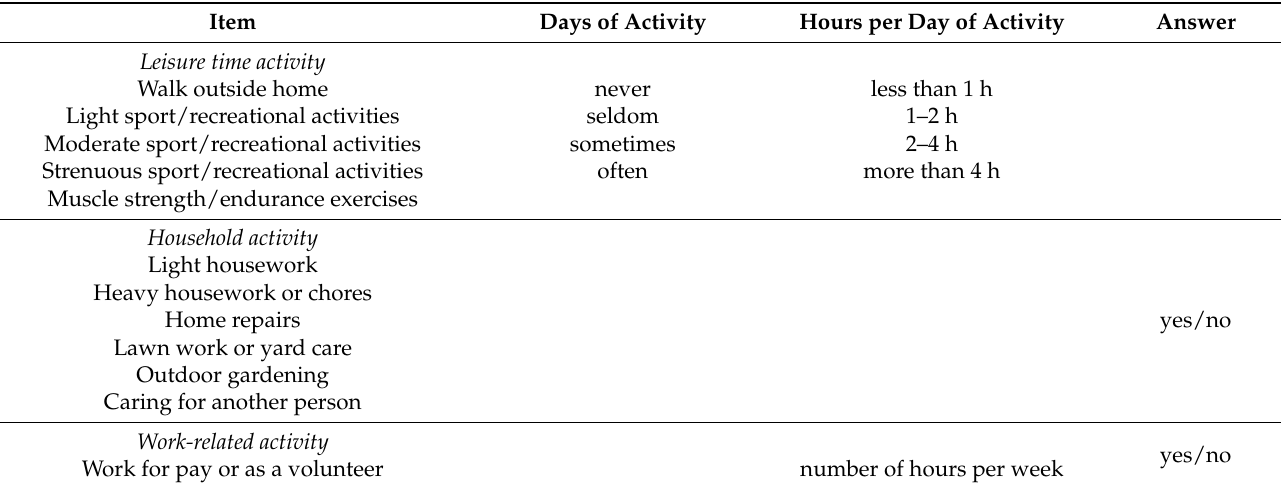
Table 1. Items of the Physical Activity Scale for the Elderly